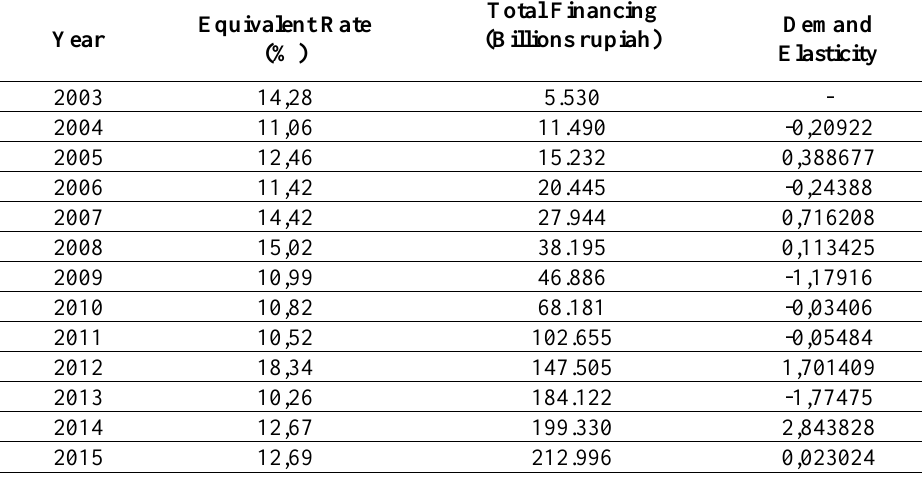
Table 1 Development of Islamic Banking